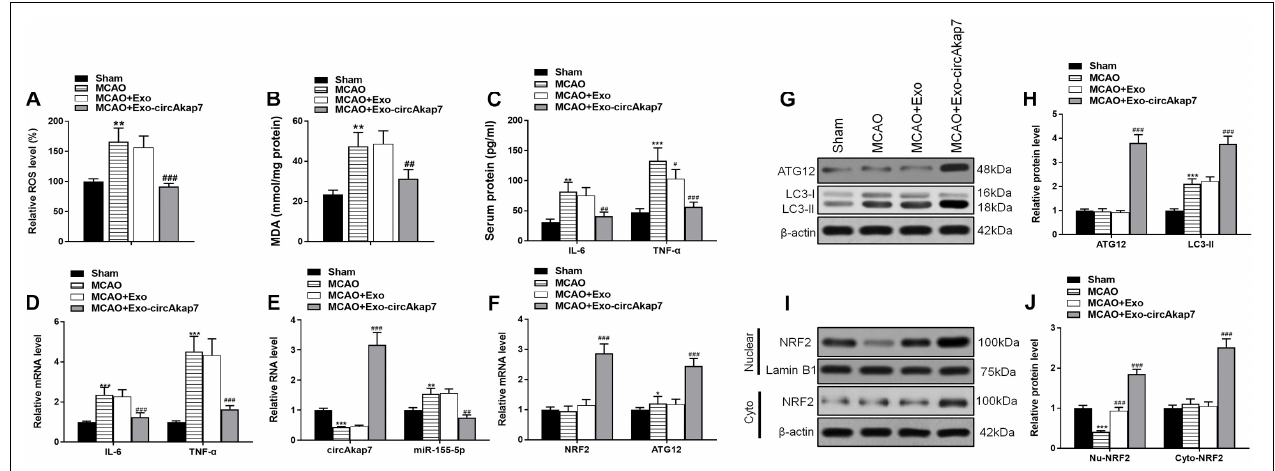
FIGURE 4 | Treatment with exo-circAkap7 attenuates oxidative stress and enhances autophagy. (A) Brain ROS levels. (B) Brain MDA levels. (C) ELISA results showing the serum expression levels of IL-6 and TNF- α in mice. (D) RT-PCR results showing the mRNA expression levels of IL-6 and TNF- α in brain tissue. (E,F) RT-PCR results showing the levels of circAkap7, miR-155-5p, ATG12, and NRF2 in brain tissue. (G,H) The expression of ATG12 and LC3B as analyzed by western blot and quantified. (I,J) The expression of cytosolic and nuclear NRF2 as analyzed by western blot and quantified. Data are expressed as the mean ± SEM, n = 8 mice. * p < 0.05, ** p < 0.01, *** p < 0.001 vs. sham, # p < 0.05, ## p < 0.01, ### p < 0.001 vs.